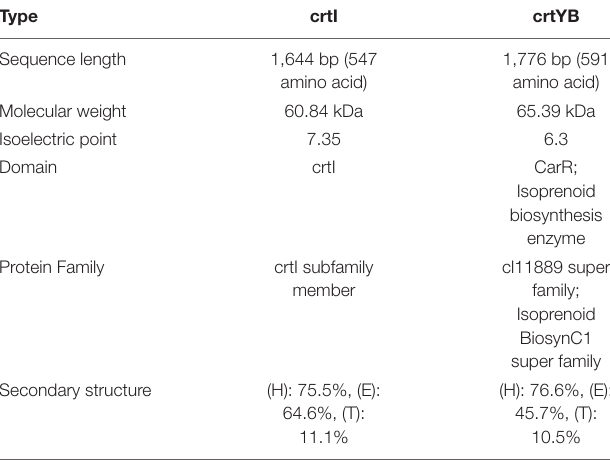
TABLE 4 | Functional analysis of crtI and